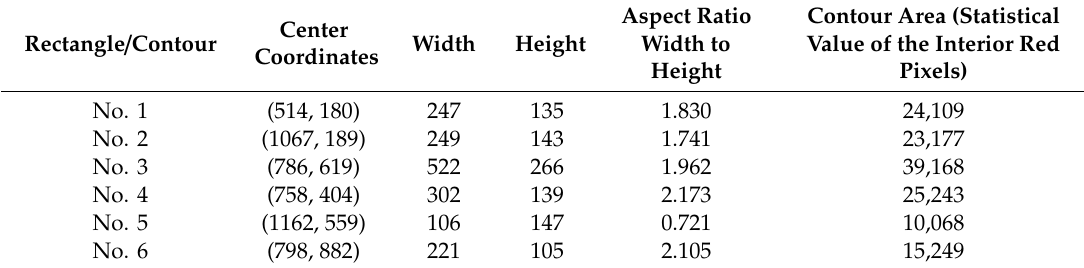
Table 2. Parameters of contours in Figure 7b (unit /